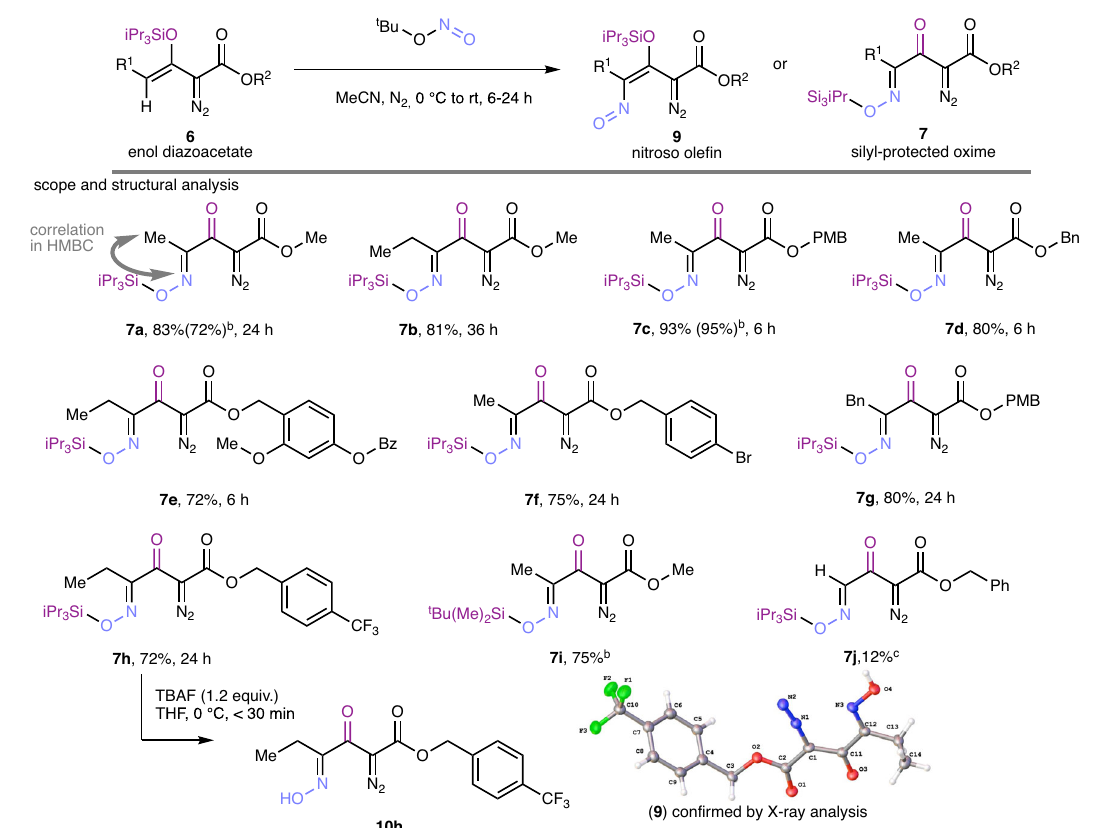
Fig. 2 | Formation of vicinal 1-ester-2-diazo-3-keto-4-oximes from β -siloxy- α - diazovinylacetates with tert -butyl nitrite. a . Investigations on the applicability and structural con fi rmation, desilylation with TBAF and x-ray diffraction. Reaction conditions: t BuONO (3.5 equiv.) was added to a solution containing 6 (0.4mmol)